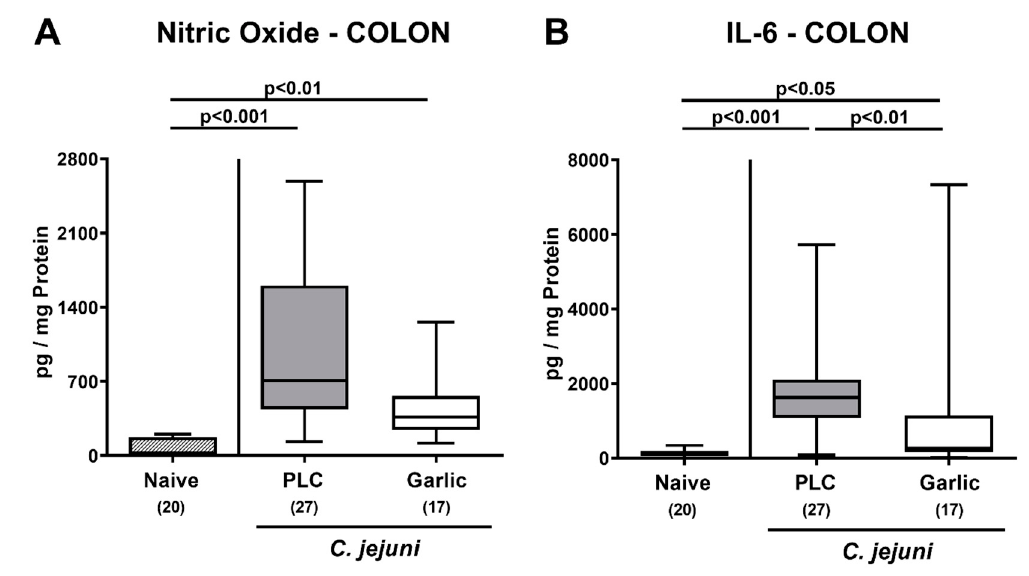
Figure 5. Pro-inflammatory mediator secretion in the colon upon garlic essential oil treatment of C. jejuni infected IL-10 -/- mice. Secondary abiotic IL-10 -/- mice were orally challenged with C. jejuni strain 81–176 on days 0 and 1 followed by treatment with either garlic essential oil (white boxes) or placebo (PLC, gray boxes) via the drinking water starting on day 2 post-infection. ( A ) Nitric oxide and ( B ) IL-6 concentrations were determined in culture supernatants of colonic explants taken on day 6 post-infection. Naive mice (hatched boxes) served as non-infected and untreated cohort. Box plots (indicating the 25th and the 75th percentiles), whiskers (indicating maximum and minimum values), medians (black bar inside box), significance levels ( p values) determined by the Kruskal-Wallis test and Dunn’s post-correction and the total number of mice (in parentheses) are shown (pooled data from four independent experiments).